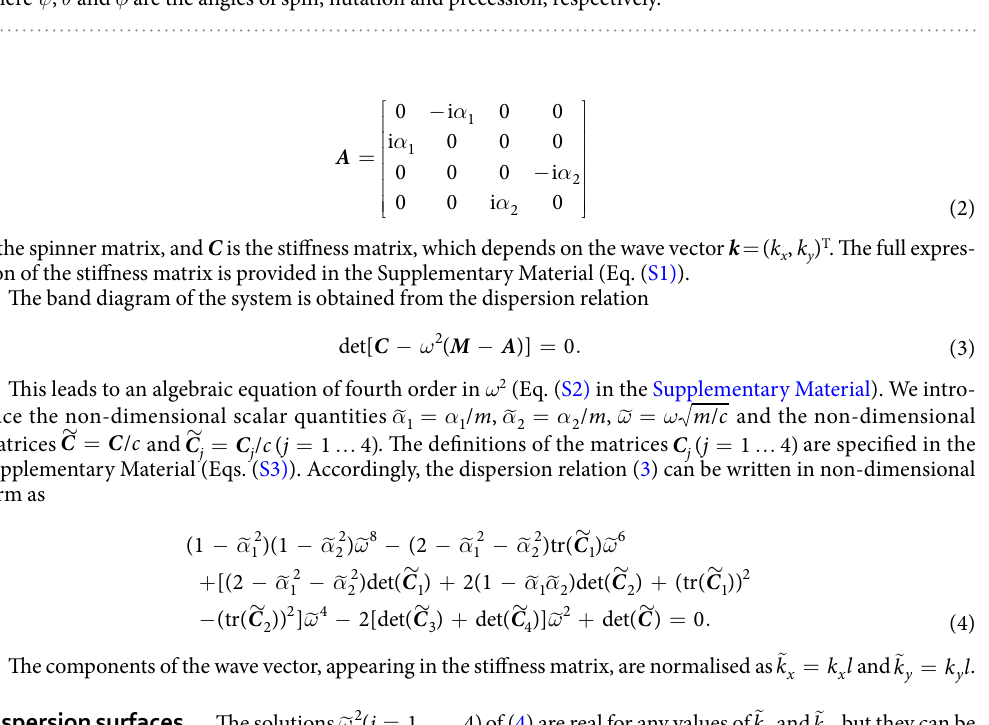
Figure 2. ( a ) Three-dimensional representation of the gyro-system, consisting of a triangular lattice connected to a system of gyros; ( b ) periodic unit cell of the system; ( c ) schematic representation of a gyroscopic spinner, where ψ , θ and φ are the angles of spin, nutation and precession,